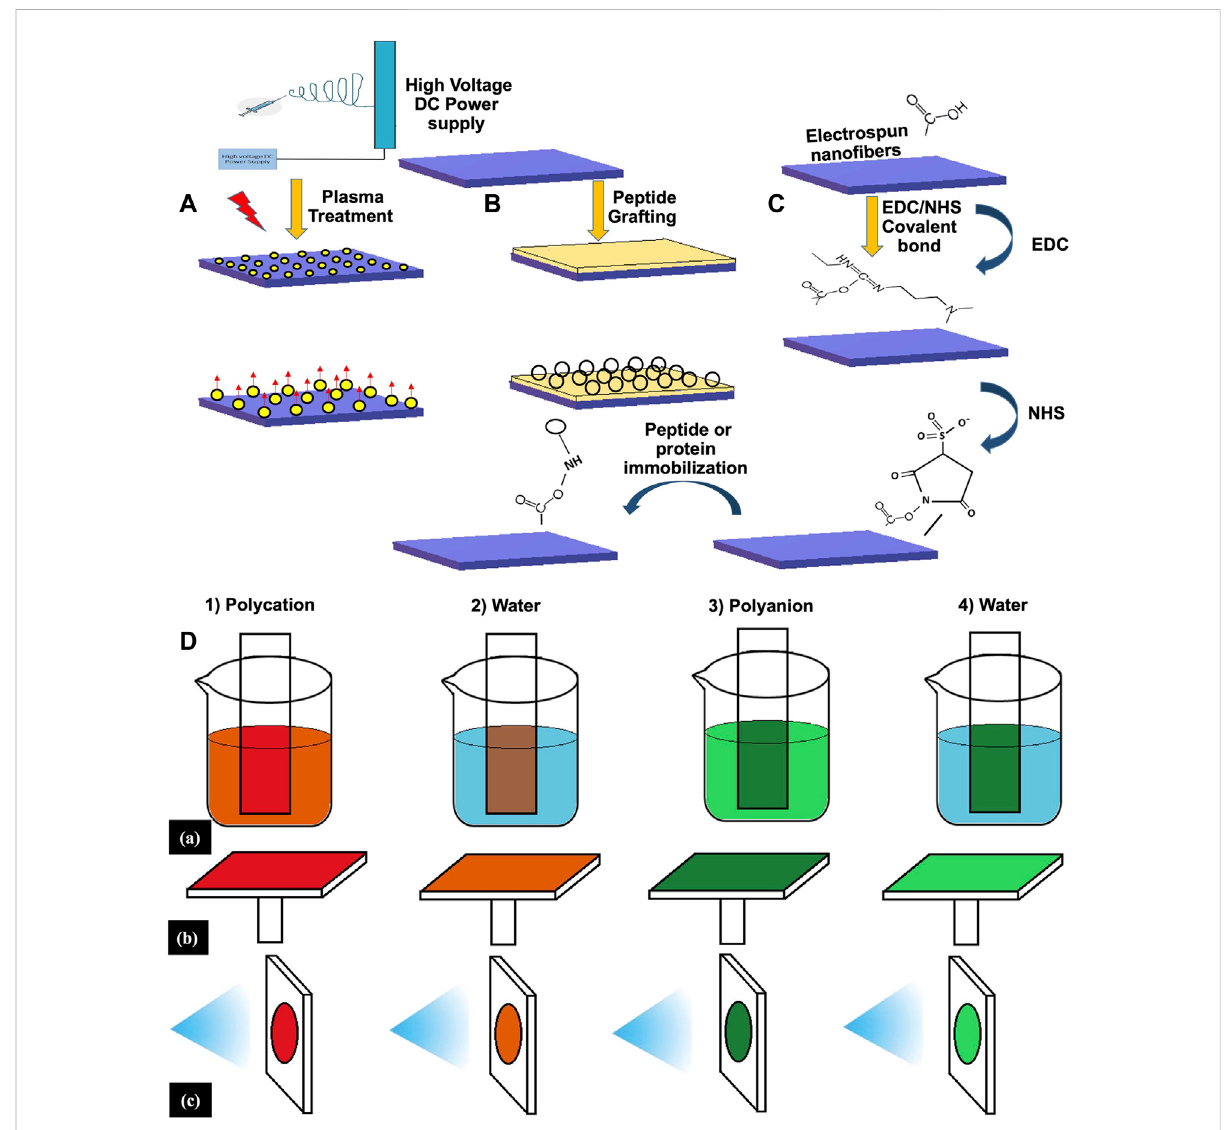
FIGURE 7 Different doping techniques of scaffold surface: (A) Plasma treatment; (B) ; Peptide Grafting; (C) EDC-NHS Coupling; (D) Layer-by-layer assembly.